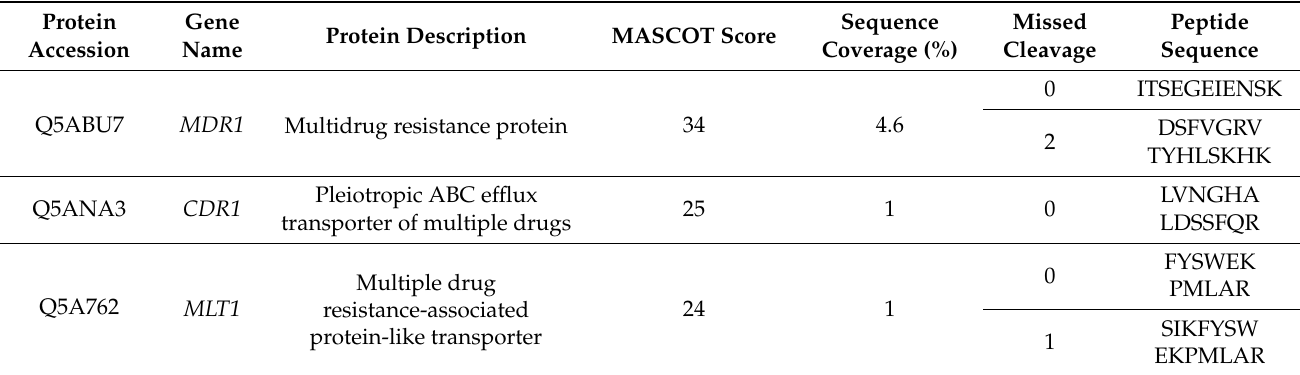
Table 4. Efflux pumps and transporters were identified in the fluconazole-resistant C. albicans strain. All proteins were identified using MASCOT.